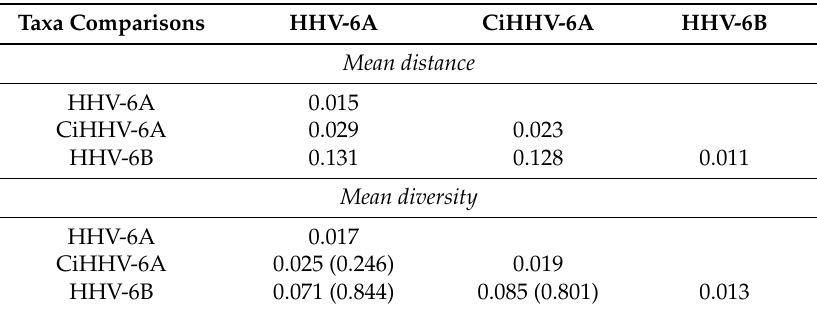
Table 2. Distance and diversity measurements in group taxa